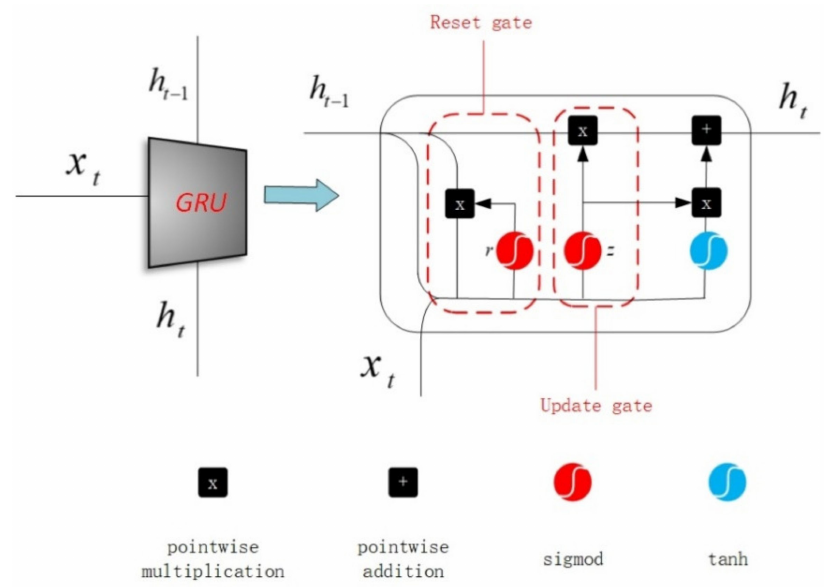
Figure 5. Illustration for gated recurrent unit